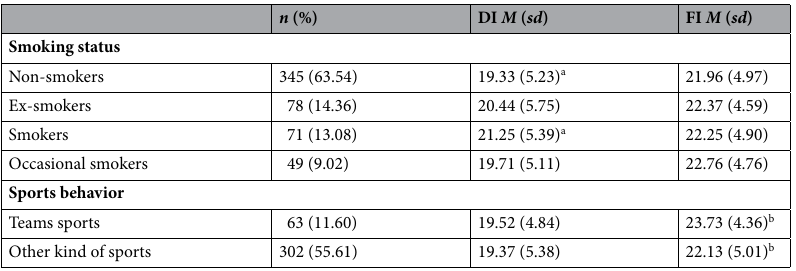
Table 4. DII scores as a function of smoking status and sports behavior. DI dysfunctional impulsivity, FI functional impulsivity. a Significantly different from each other, p = 0.018 (Dunn’s post-hoc test; Bonferroni- adjusted). b Significantly different from each other, p = 0.015